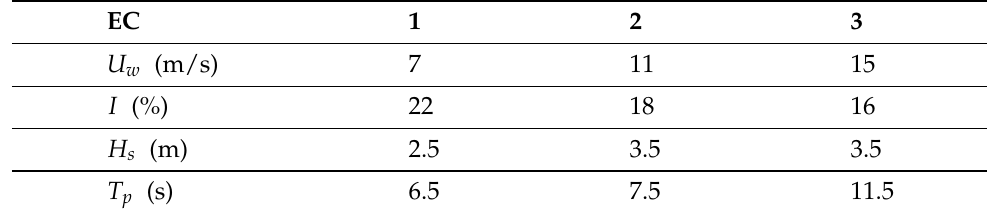
Table 1. Environmental conditions for drivetrain